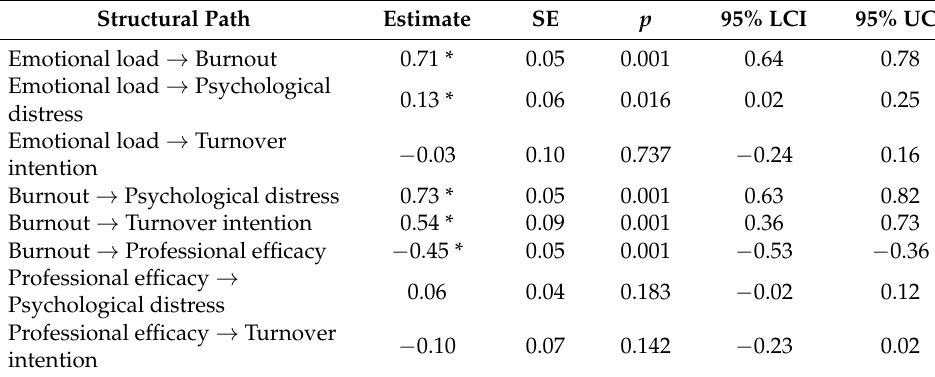
Table 3. Structural path results with 95% confidence intervals.